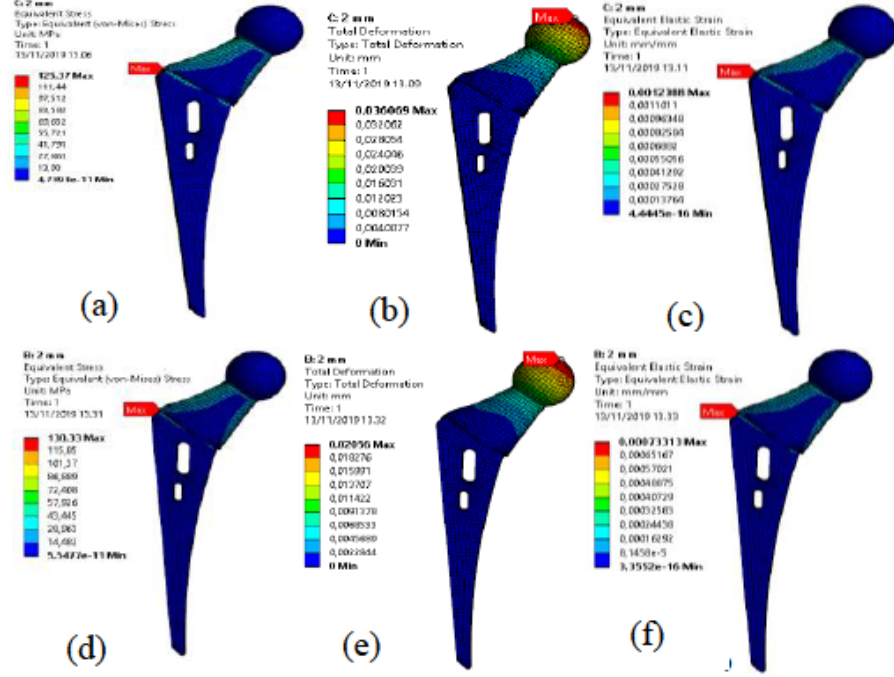
Figure 11: For element size 2 mm on Ti-6Al-4V (a) Stress (von misses), (b) deformation, (c) strain (von misses) and on SS 316 L 4V (d) Stress (von misses), (e) deformation, (f) strain (von